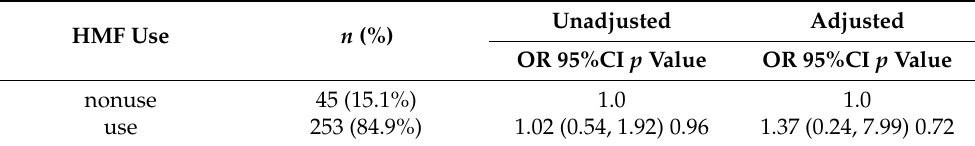
Table 3. Univariate and multivariate logistic regression to assess the association of the HMF use with FI. Dates, 2015–2018.